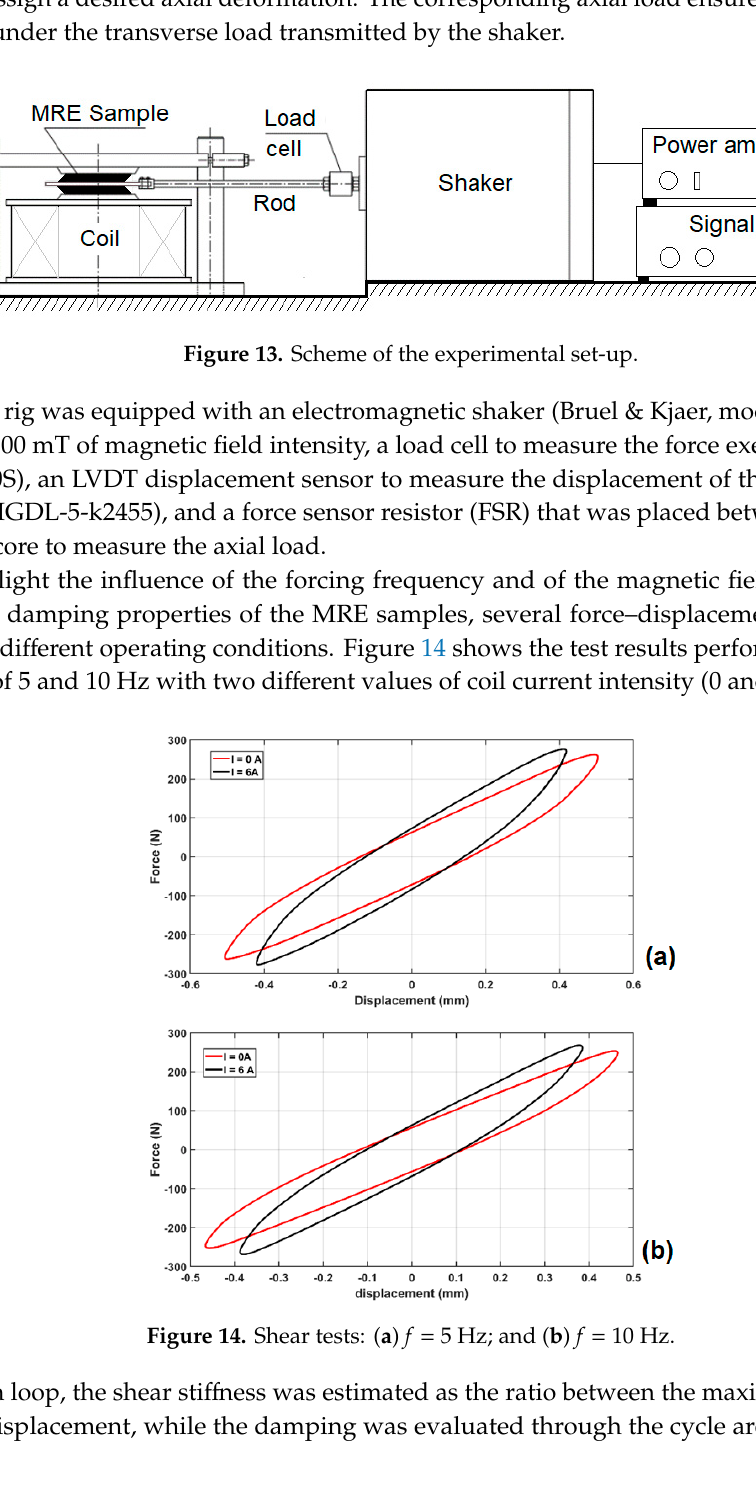
Figure 15. Stiffness vs. frequency.